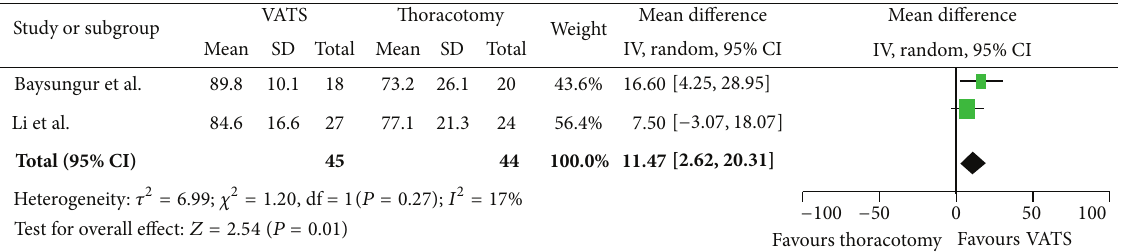
Figure 5: Forest plot for cognitive function scale comparing VATS to